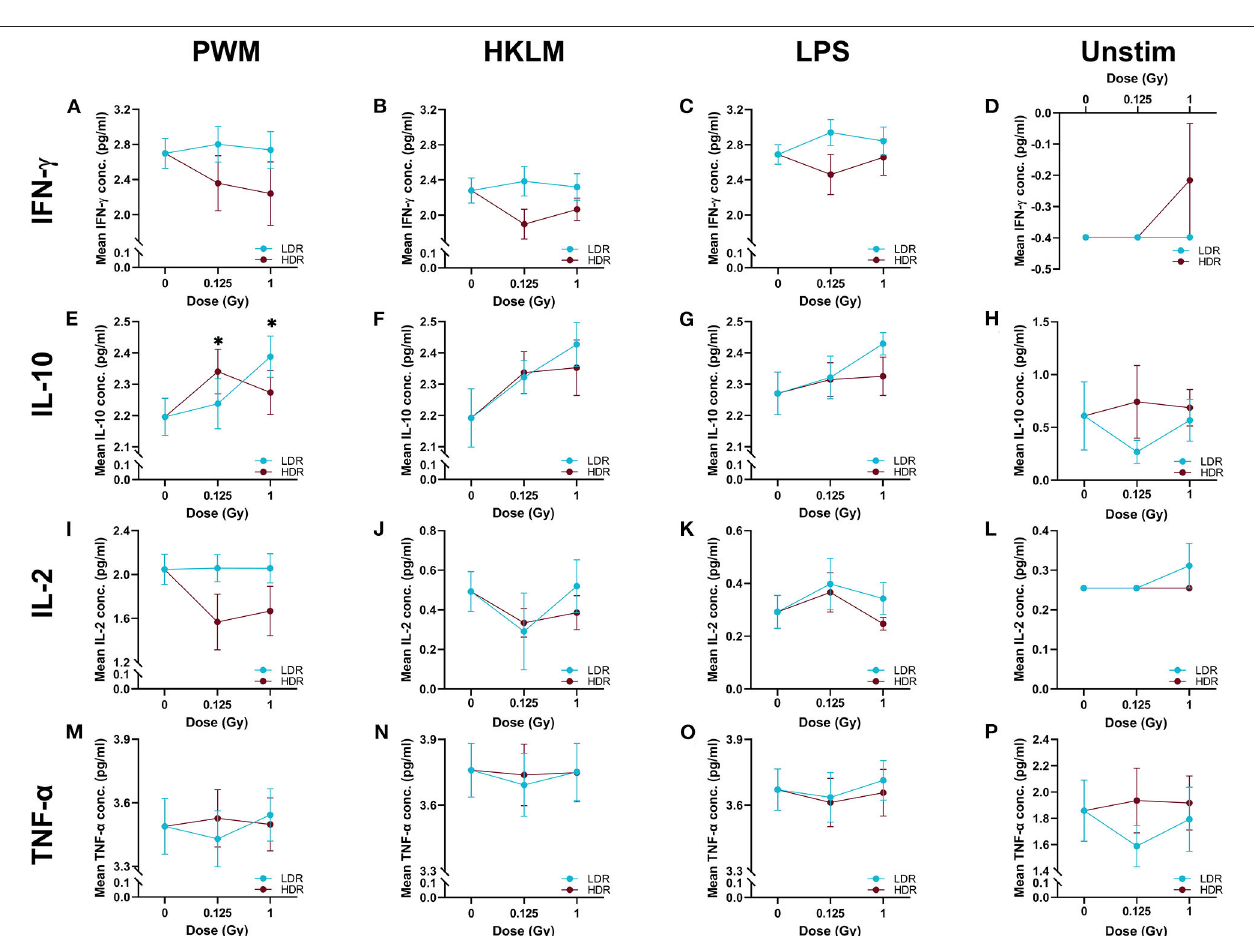
FIGURE 3 | The log 10 -transformed mean cytokine concentrations. The above figures display the mean IFN- γ , IL-10, IL-2, and TNF- α titres in the stimulated ( n = 8) and unstimulated ( n = 6), irradiated and sham-irradiated groups, with error bars indicating the SEM. When stimulated with PWM, 0.125Gy neutrons given at the higher dose rate and 1Gy given at the lower dose rate, significantly increase IL-10 secretion (* P < 0.05) when compared to the sham-irradiated control (Graph E ). Graphs (A) to (D) and (F) to (P) display no significant relationships. trend. For some of the donors, the measured values were still levels in whole blood cultures [55]. This was indeed observed below the assay detection limit of 1.8 pg/ml after 24 h of for three of the four measured cytokines (IFN- γ , IL-10, and TNF- α ), irrespective of the stimulant used for lymphocyte stimulation and out of the normal physiological range for healthy activation ( Figure 2 ). IL-2 concentrations deviated from this adults (9.4–15.9 pg/ml) [56]. Minor, non-significant increases